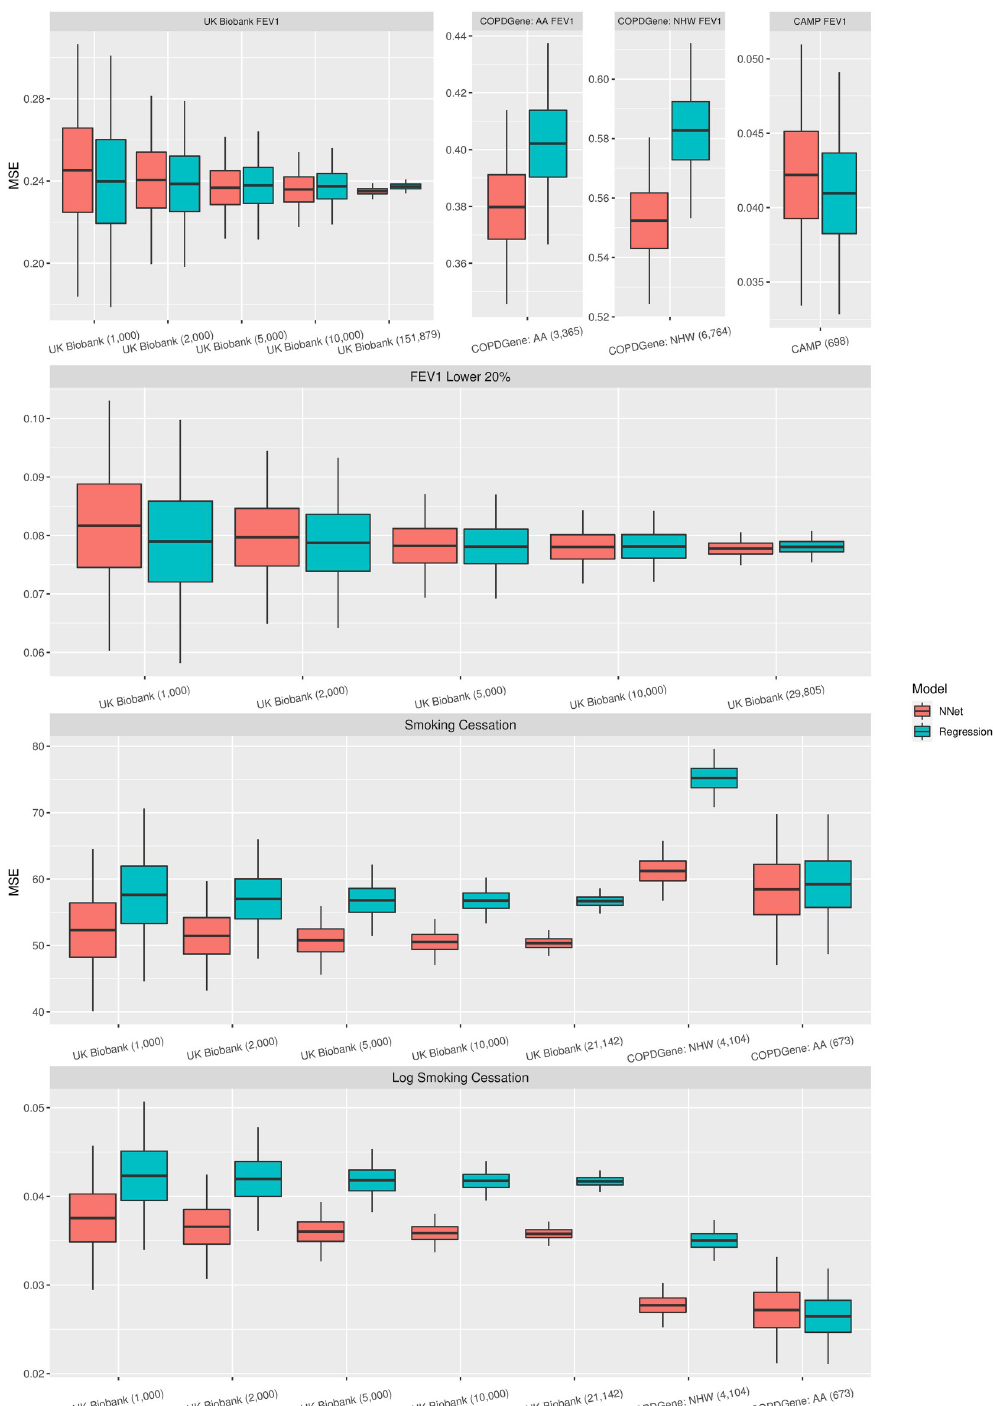
Fig 2. This figure includes box plots of the MSE for the different studies and outcomes when 50% of the data was used to train the models.